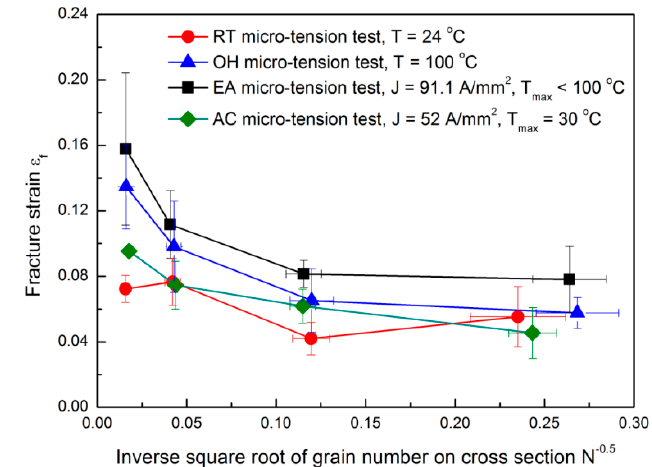
Figure 2. The fracture strain behavior for the different tested configurations.